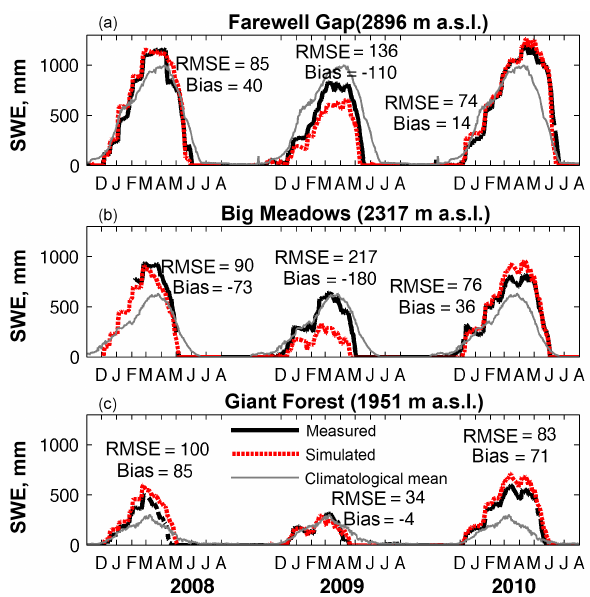
Figure 3. Measured and simulated SWE at the three automated snow stations spanning the middle elevations of the greater Kaweah River basin. The error metrics RMSE and bias, in millimeters, are provided for each station-year. The thin gray line indicates the long- term climatological mean SWE based on 26 years of data (1988– 2014) collected at the Giant Forest and Big Meadows stations and a 15-year record (2000–2014) at the Farewell Gap